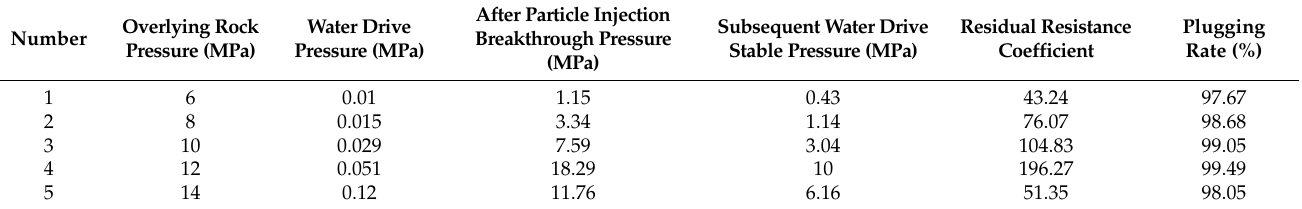
Table 12. Plugging performance of water-swellable rubber particles under different overburden